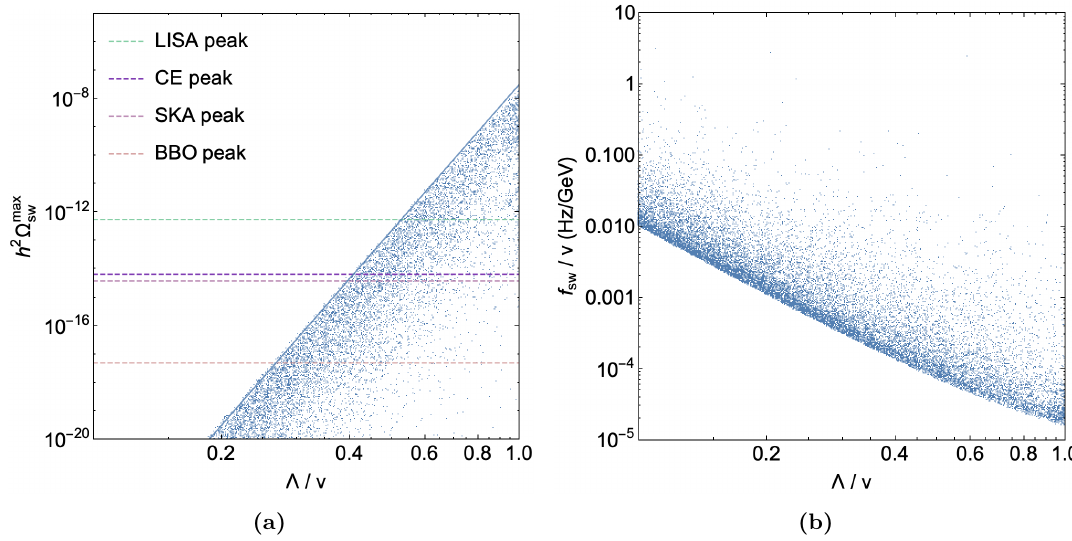
(left) and f (right) against Λ /v for a set of models obtained by Figure 7. Plot of h 2 Ω max sw /v sw scanning of 0 ≤ Λ /v ≤ 1 , − 5 ≤ b ≤ 0 and 0 ≤ c ≤ 25 . The dashed lines in the left panel are the maximum sensitivities of LISA (green), BBO (beige), SKA (magenta) and CE (purple). The solid blue line in the left panel presents the maximum value of h 2 Ω max obtained for a given Λ /v , for sw any ( b, c ) ; this line has a slope of ∼ 17 . 2